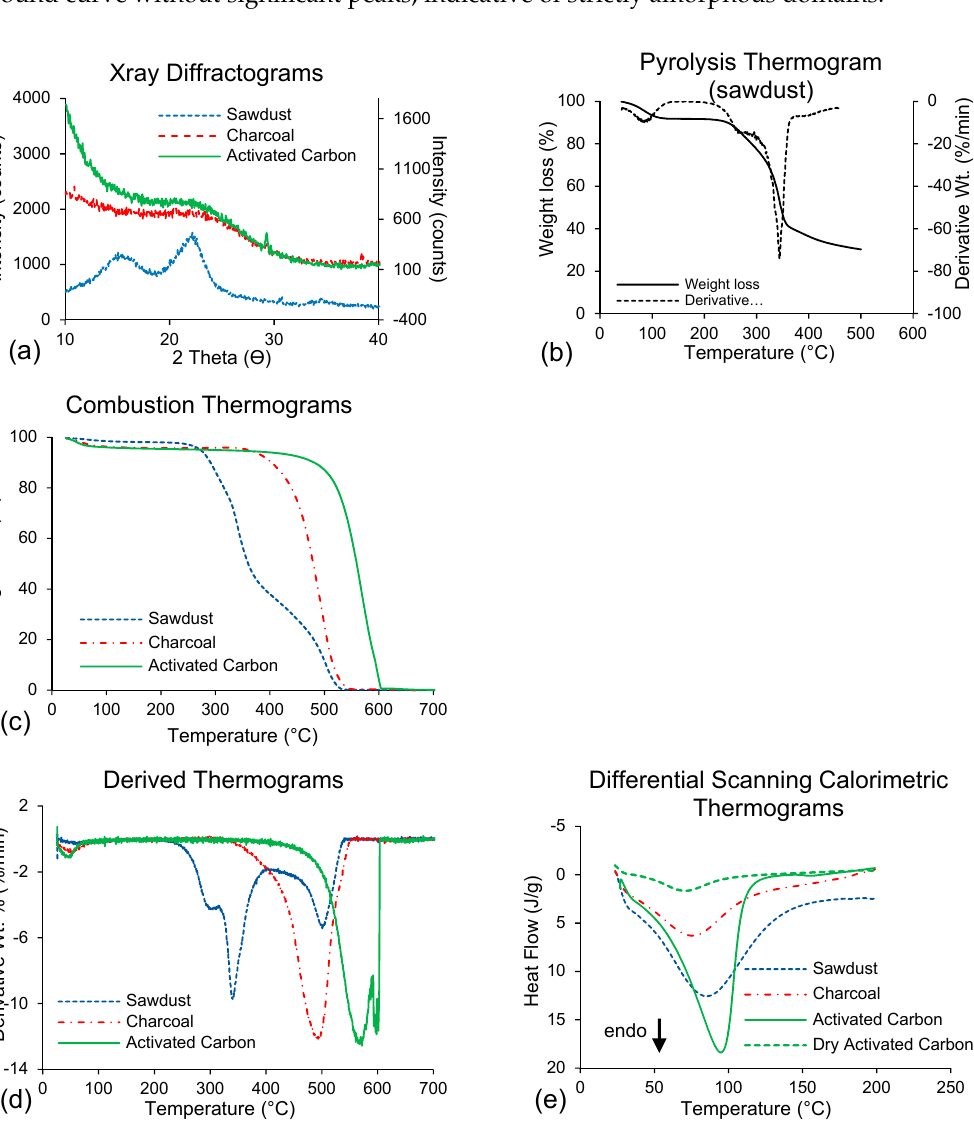
Figure 4. Graphic analyses demonstrating physical properties of massaranduba ( Manilkara huberi ) sawdust and its products (charcoal and activated carbon): ( a ) X-ray diffractograms; ( b ) Thermogravimetric Pyrolysis analysis-Py-TGA (only for sawdust); ( c ) Thermogravimetric Combustion analysis (Co-TGA) ( d ) Derived thermogravimetry of combustion (Co-DTDA); ( e ) Differential Scanning Calorimetry of combustion (Co-DSC).